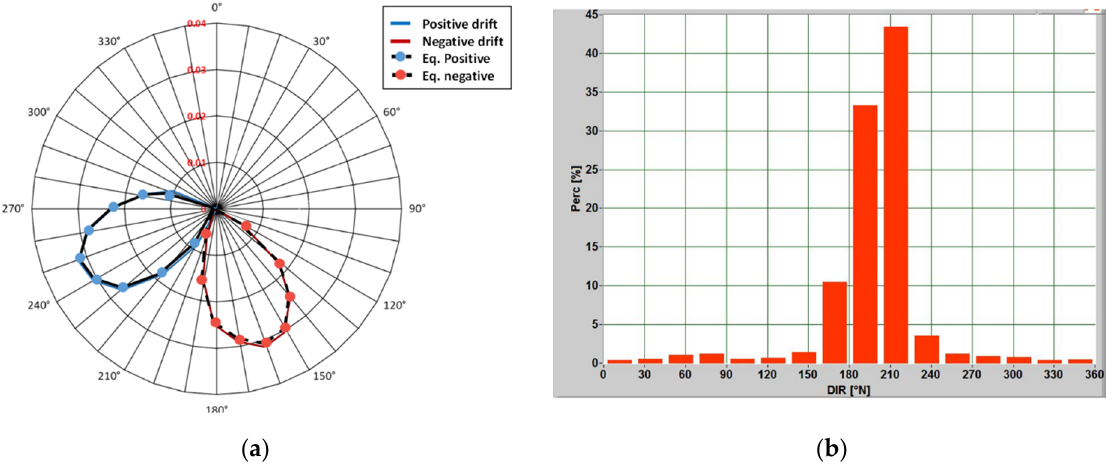
Figure 5. ( a ) Single-component approximation for Bagnoli Bay (Napoli); ( b ) histogram of wave directions.